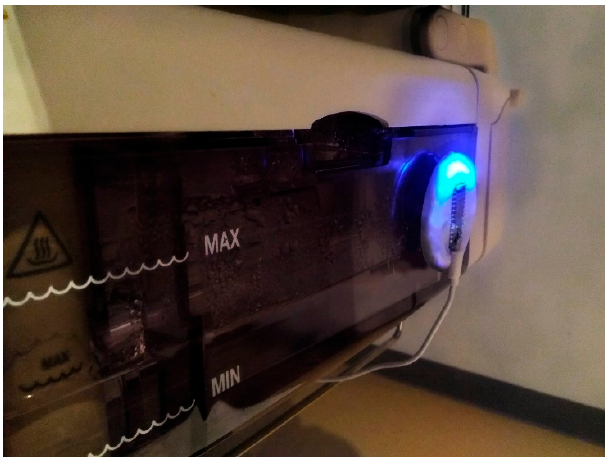
Figure 1. CheckMate attached to one of the medical devices; the water container of an incubator.